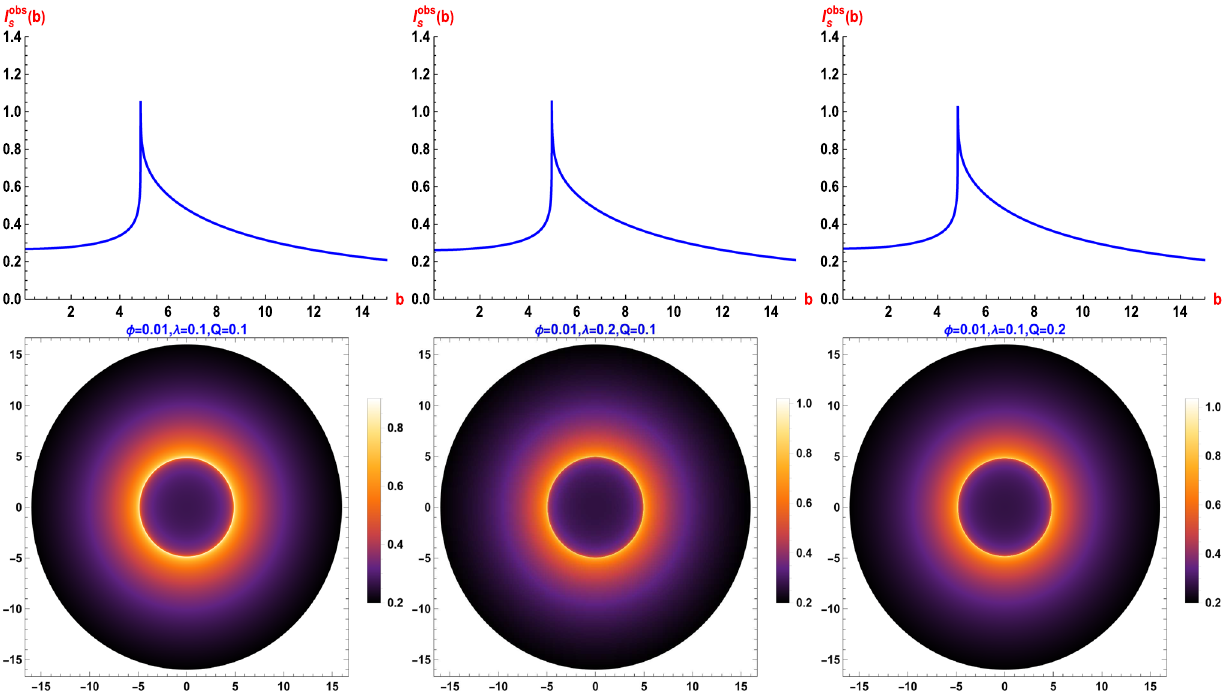
Fig. 8 Profiles of the specific intensity I obs s ( b ) , cast by a static spherical accretion mechanism, under some specific values of BH parameters as three instant examples with M = 1. The details can be found in the main text